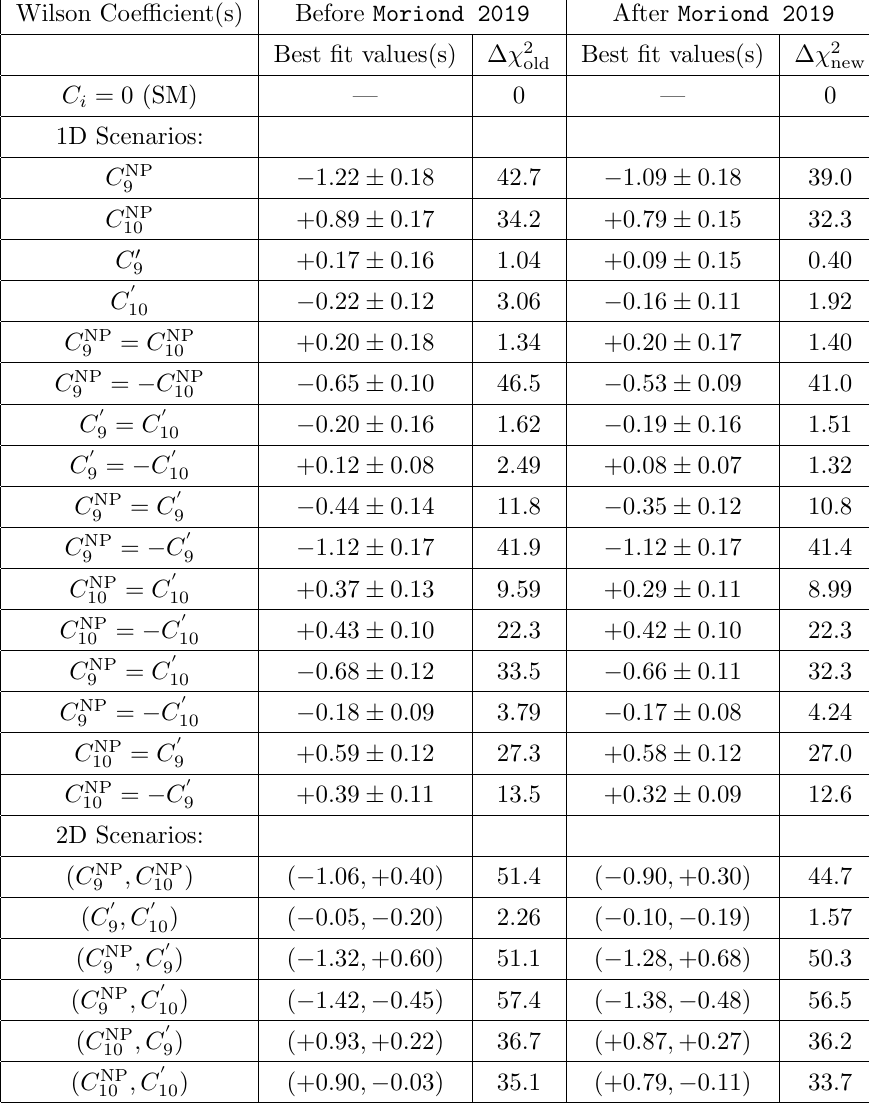
Table 1 . Best (cid:12)t values of new WCs in various 1D and 2D scenarios. The improvement over SM is quanti(cid:12)ed by (cid:1) (cid:31) 2 (cid:17) (cid:31) 2 (cid:0) (cid:31) 2 . For 1D scenarios, the 1 (cid:27) allowed ranges of the relevant WC are SM bf also provided. With the 2019 Moriond update, the value of (cid:31) 2 goes from 157 to 156. SM